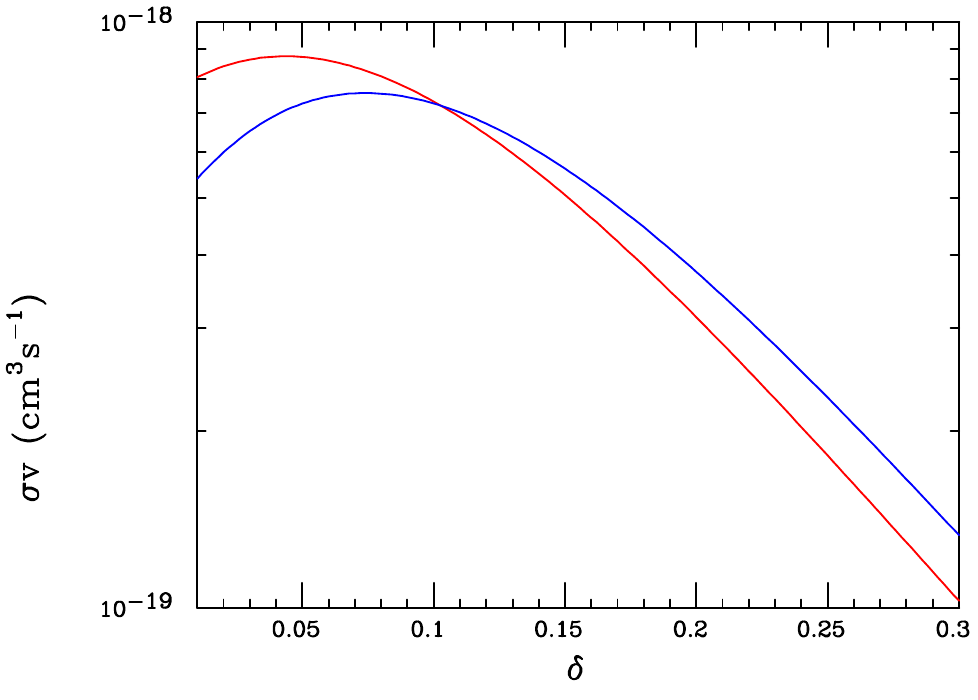
Figure 13 . Thermally averaged h 1 a 1 ! e + e (cid:0) annihilation cross sections for the BM1(red) and BM2(blue) points generalized to functions of the parameter (cid:14) in units of ( g D (cid:15) 1 =m h